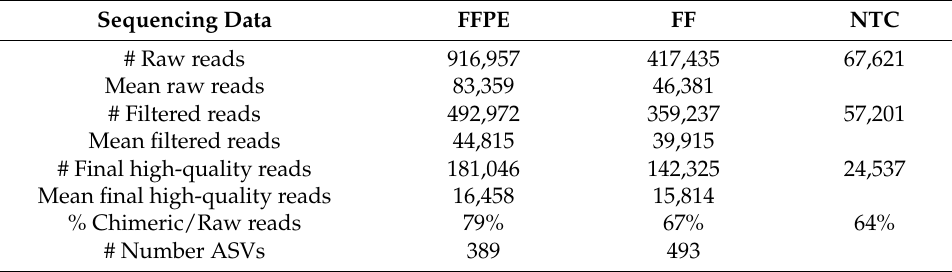
Table 1. Sequencing statistics per sample group included in this